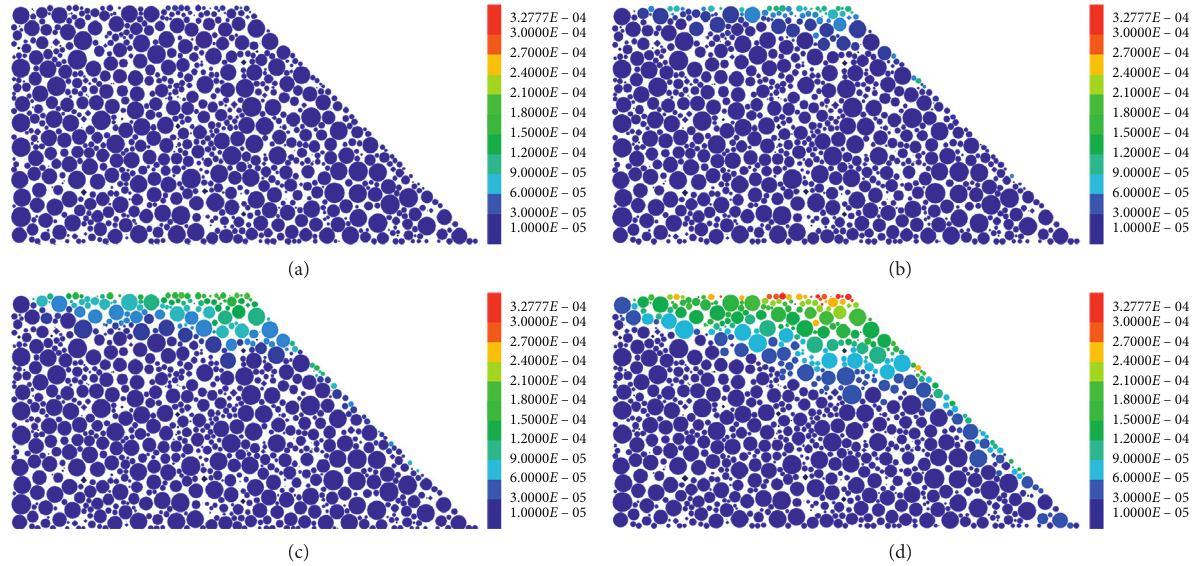
Figure 9: Vertical displacement fields in different freezing cycles. (a) 2, (b) 4, (c) 6, and (d) 8 (unit: